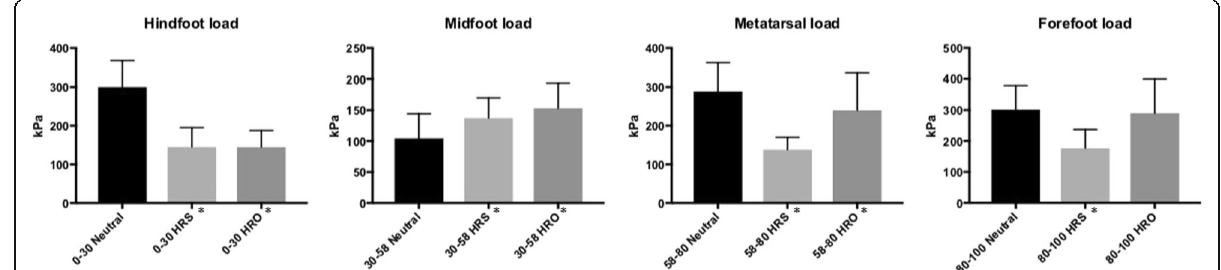
Fig. 3 Bars illustrate peak pressure values (kPa) under the hindfoot, midfoot, metatarsal zone and forefoot for the different devices (neutral shoe, HRS and HRO). *: Statistically significant difference to neutral